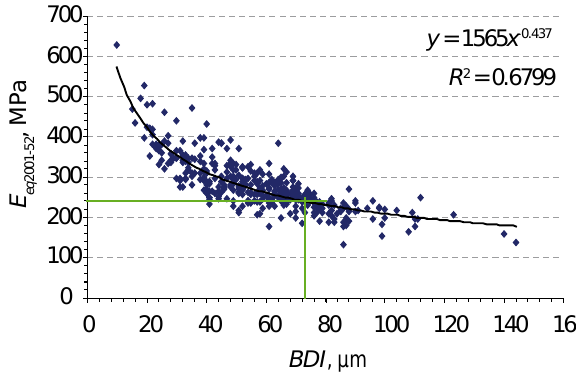
Fig. 4. E eq 2001-52 – BDI, AC , analyze group 6, with surface